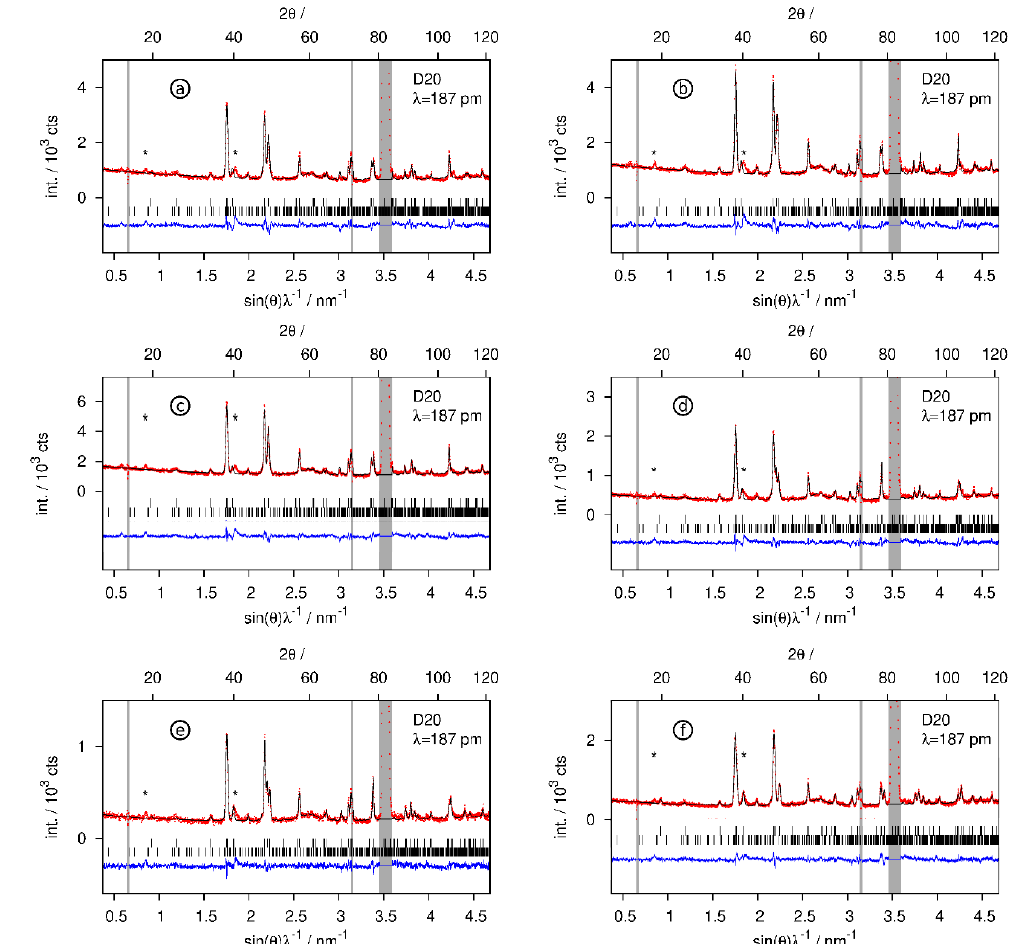
Figure 7. Rietveld refinements of the crystal structures of the deuterium-poor CaSiD x <1 phases. Neutron diffraction data were collected in situ according to the conditions given in Table 2. The grey regions correspond to contributions of the sapphire cell. (*) marks unidentified peaks already present in the pristine Zintl phase. Bragg markers: CaSiD x (top) and Ca 14 Si 17 (bottom). ( a ) CaSiD 0.126(6) (first deuteration cycle), ( b ) CaSiD 0.137(5) , ( c ) CaSiD 0.168(6) , ( d ) CaSiD 0.092(5) , ( e ) CaSiD 0.096(6) , ( f ) CaSiD 0.047(5) . Red points, observed intensity; black line, calculated intensity; blue line, difference